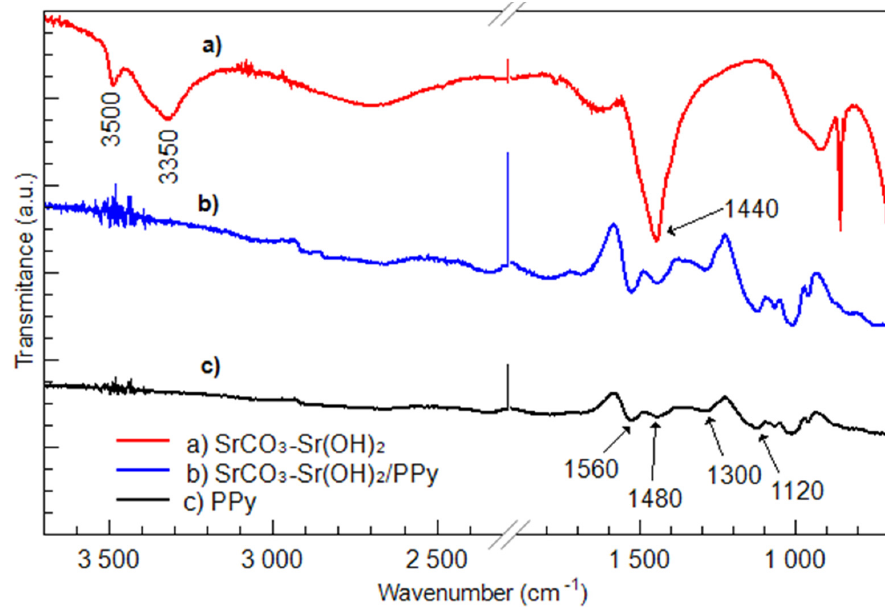
Figure 1. Fourier transform infrared (FTIR) spectra of ( a ) SrCO 3 ‐ Sr(OH) 2 ; ( b ) SrCO 3 ‐ Sr(OH) 2 /PPy